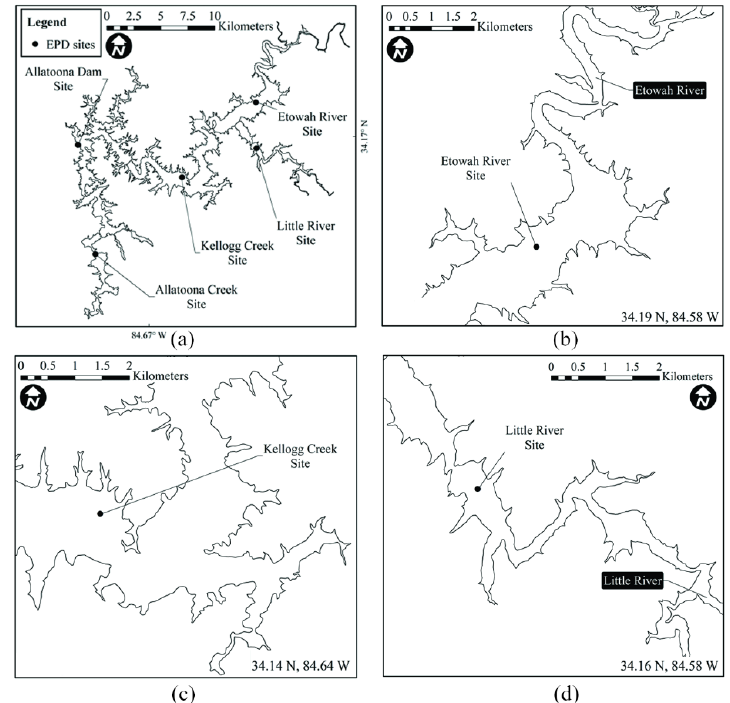
Figure 4. A field survey of water quality was conducted at Georgia Environmental Protection Division (Georgia EPD) sampling points at the major embayments of eastern Lake Allatoona. ( a ) All sites at Lake Allatoona; ( b ) The site near the Etowah tributary; ( c ) The Kellogg Creek site near central Allatoona; ( d ) The site near the Little River